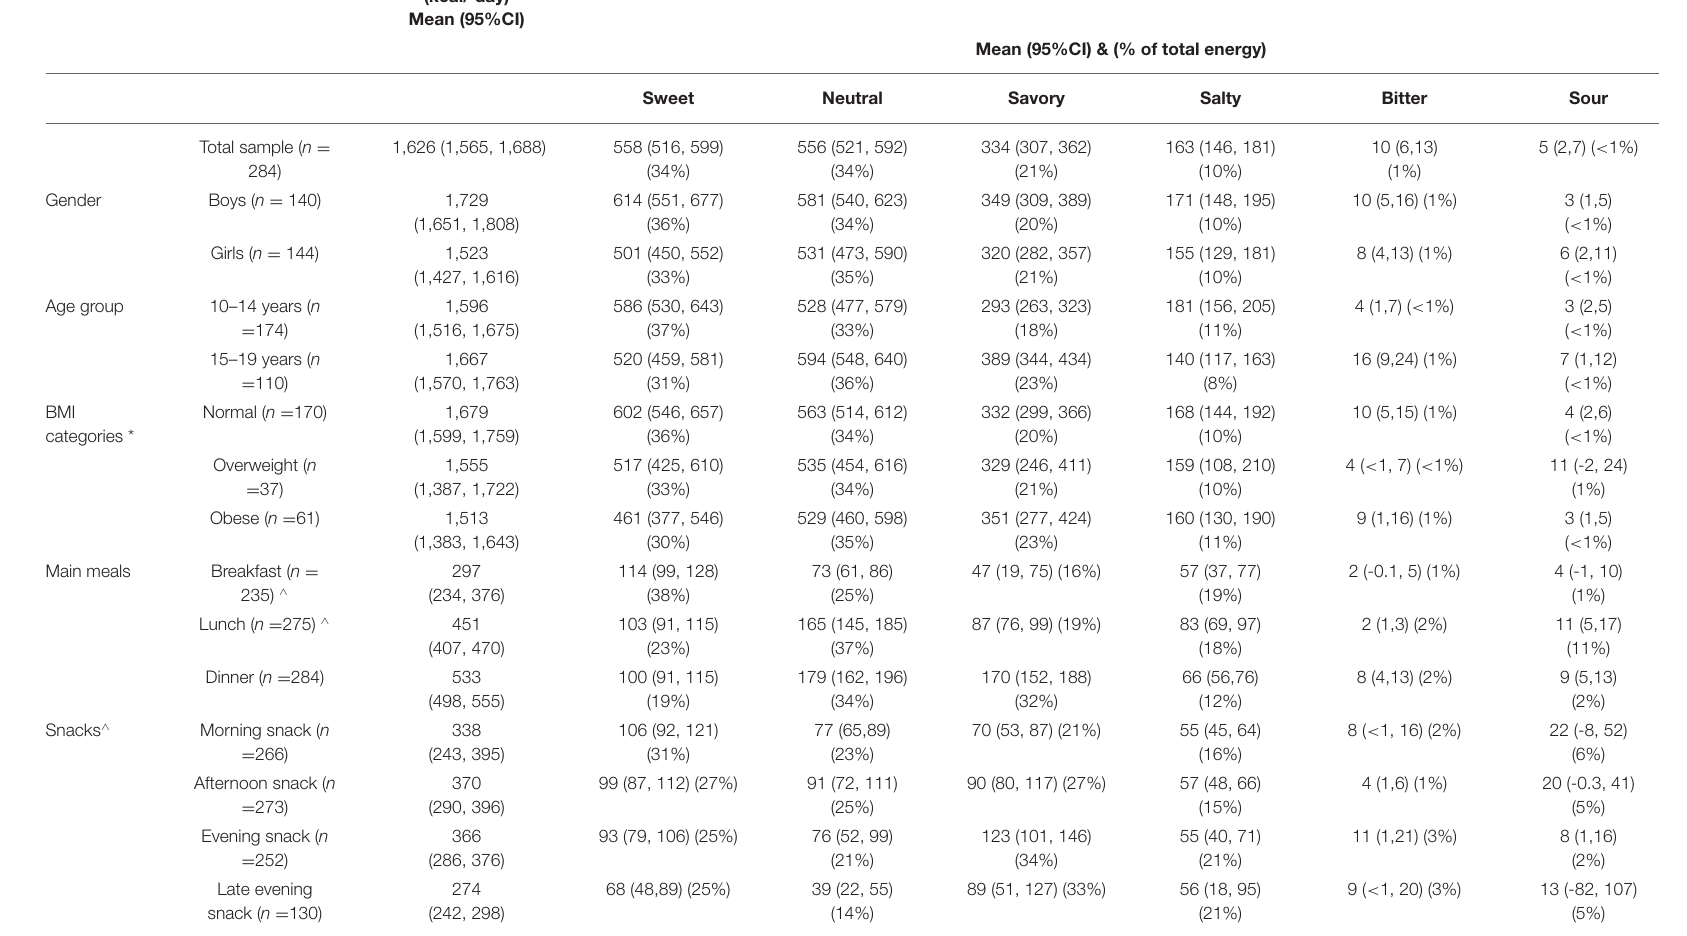
* Indicates missing data for 16 participants; ∧ Not all adolescents had consumption during the stated